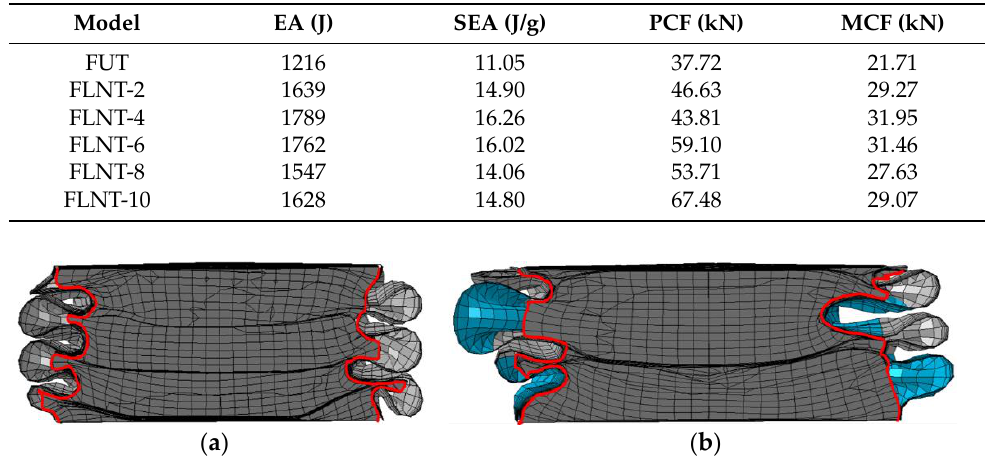
Figure 16. Deformation modes: ( a ) untreated; ( b ) FLNT-2; ( c ) FLNT-4; ( d ) FLNT-6; ( e ) FLNT-8; and ( f ) FLNT-10. Table 9. Crashworthiness data for different stripe number filled tubes.